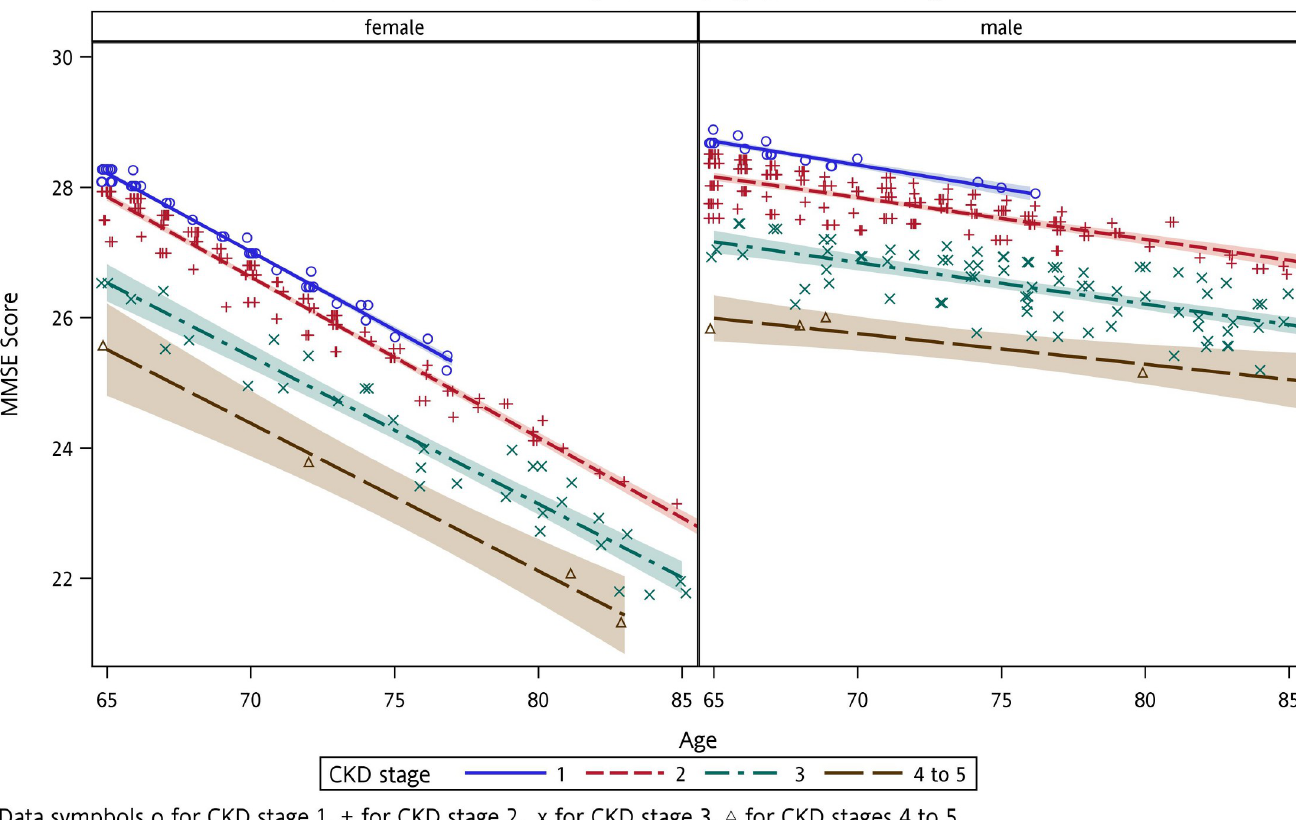
Fig 1. Global Mini-Mental State Examination (MMSE) score by age, sex, and chronic kidney disease (CKD) stages.